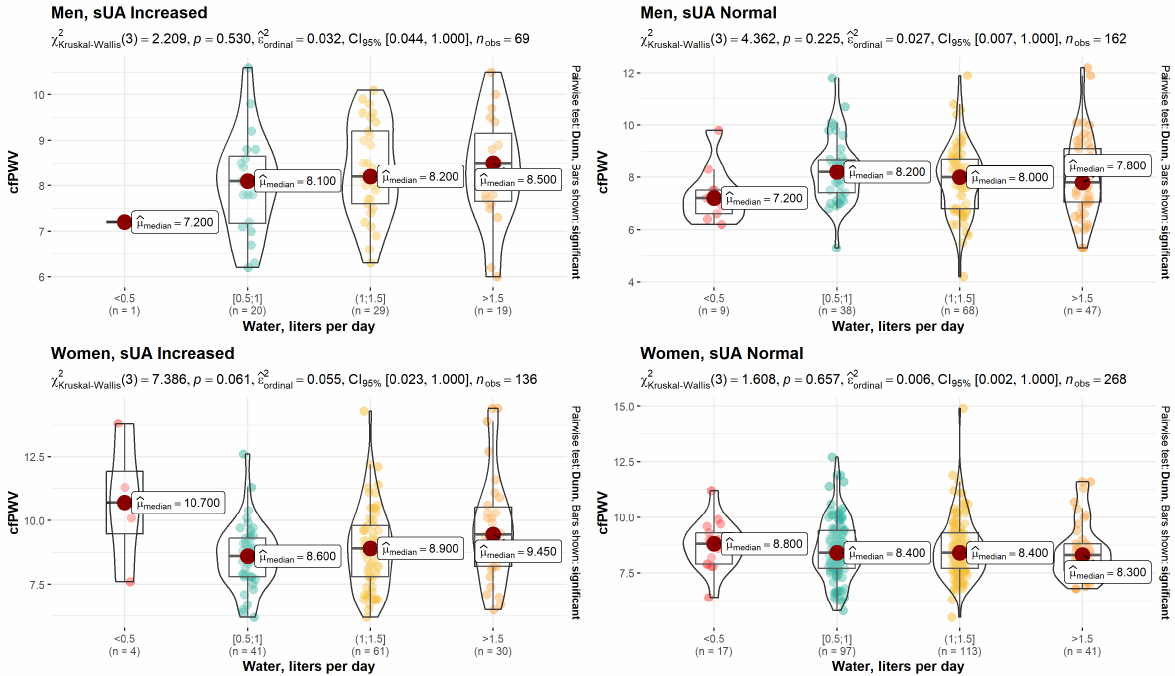
Figure 1. Dependence between water intake habits and cfPWV in patients with normal and increased sUA levels.